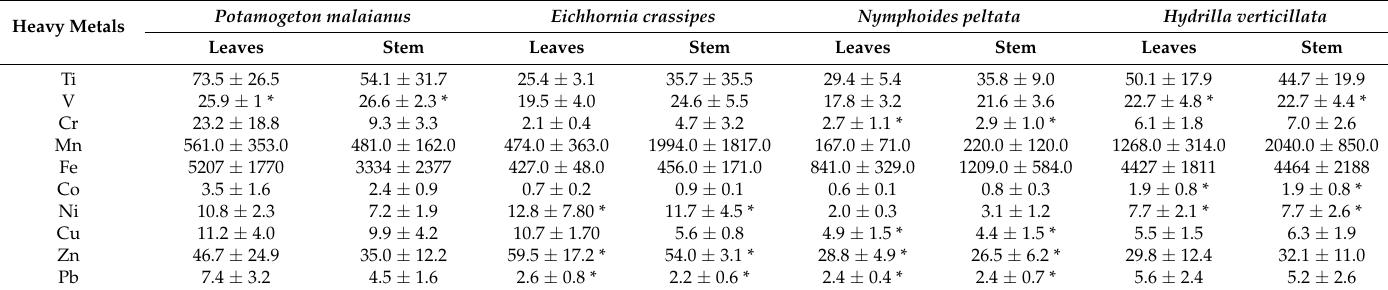
Table 3. Heavy metal concentrations in leaves and stems of the chosen aquatic plants (mg kg − 1 ,